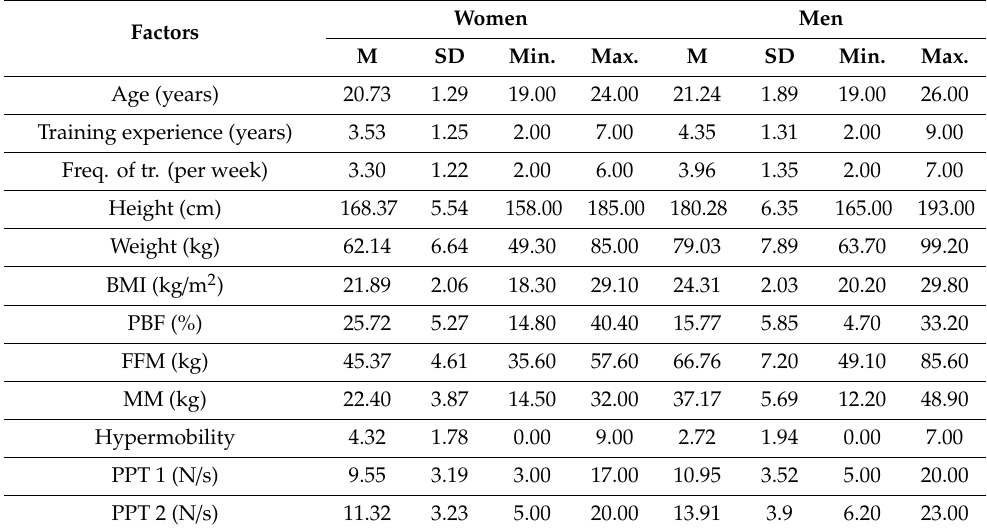
Table 1. Descriptive characteristics of the group studied, with a breakdown by sex.